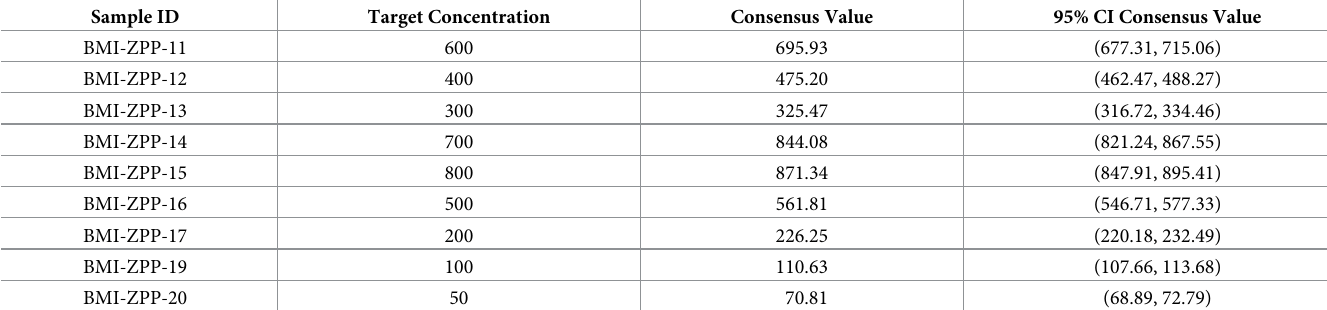
Table 6. Consensus values by test sample generated from intercept of mixed ANOVA model fit to data from all laboratories.